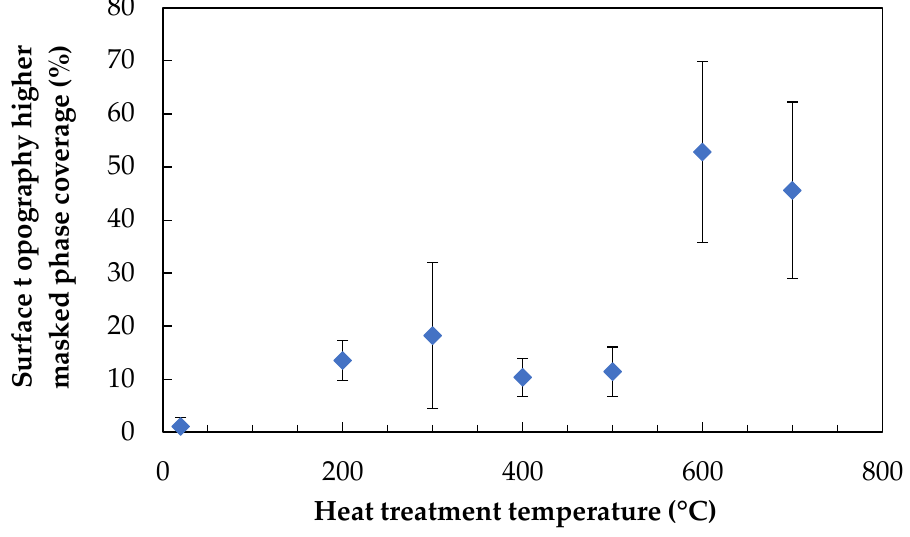
Figure 10. Coverage of the higher (masked) phase of surface topography as a percentage, over heat treatment temperature.